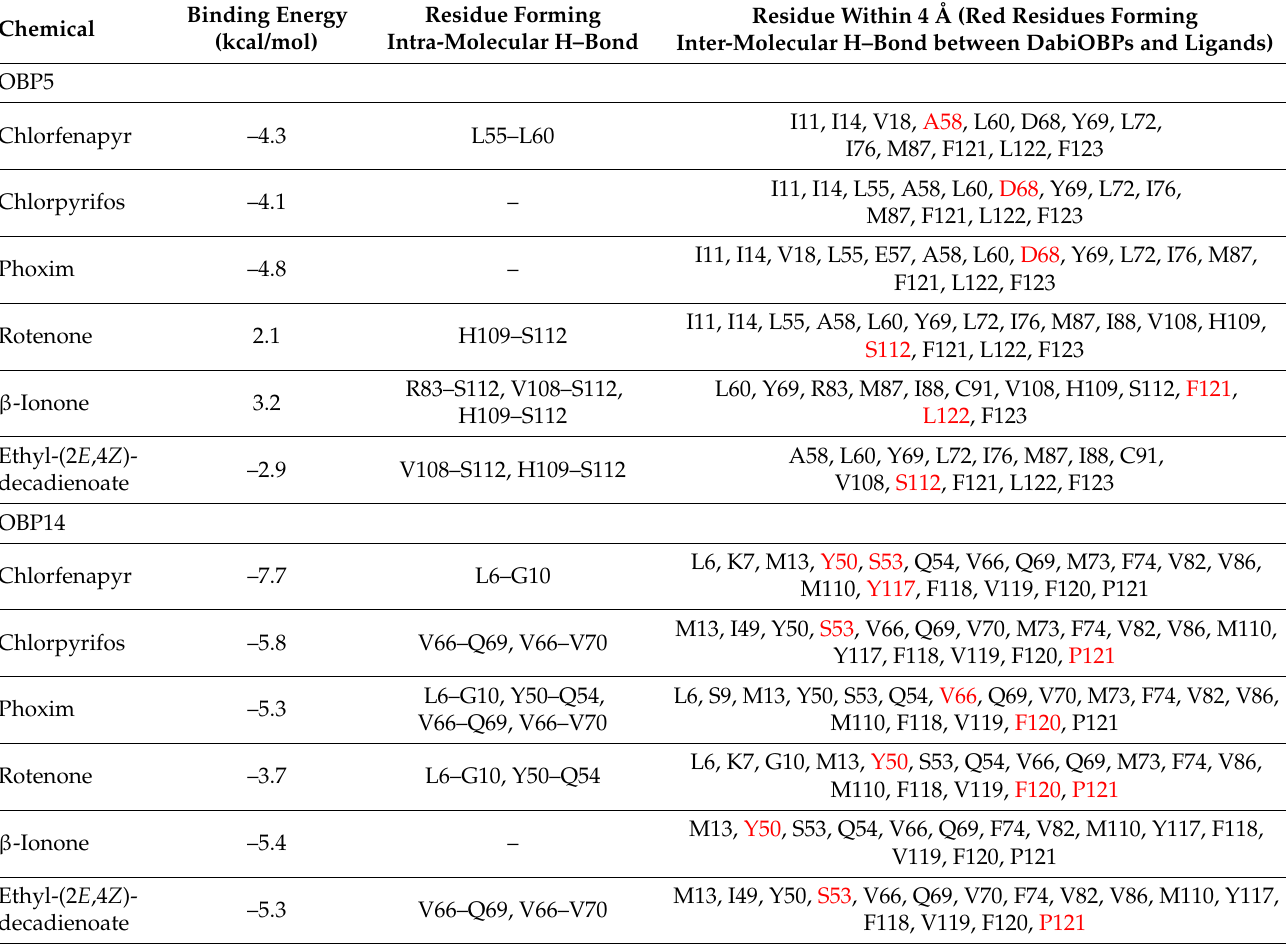
Table 1. Binding energies and key residues of DabiOBPs to the optimal